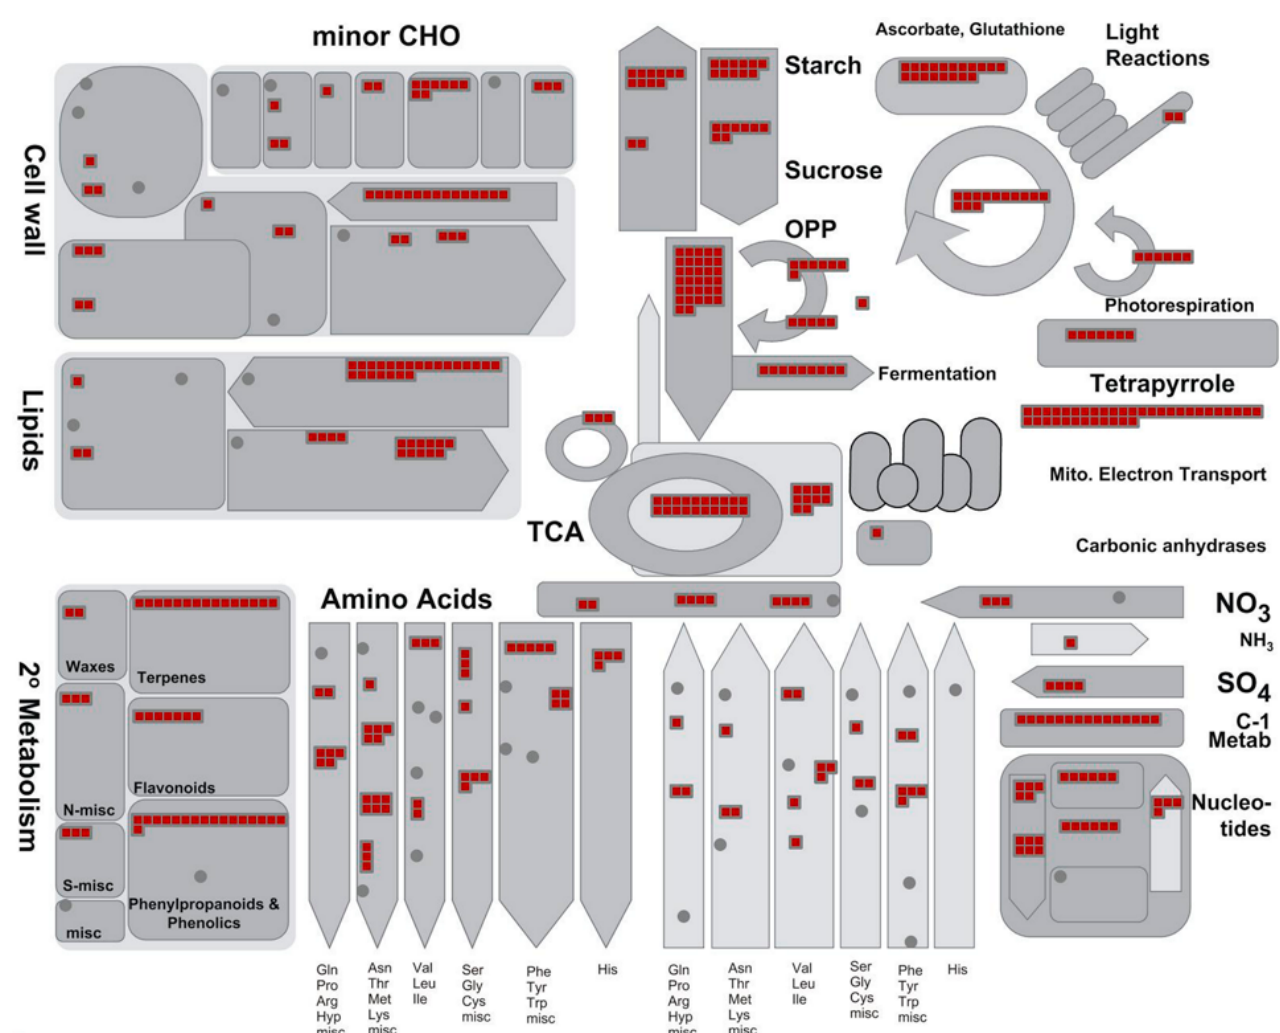
Figure 5. Proteins identified in ginseng involved in main primary metabolic pathways. The identified proteins were classified into metabolic functional classes according to the BIN ontology. The schematic metabolic pathways were obtained by MapMan software.